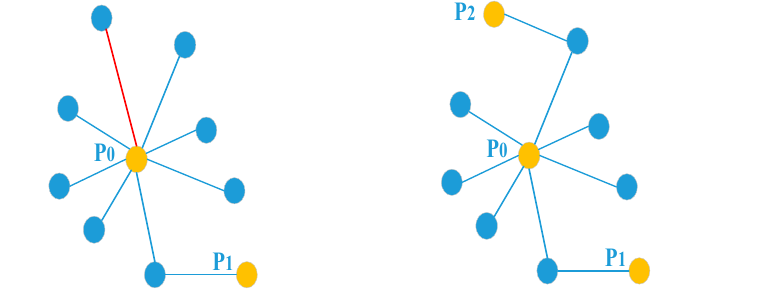
Figure 2. Extracting sampling points by the farthest point sampling algorithm.